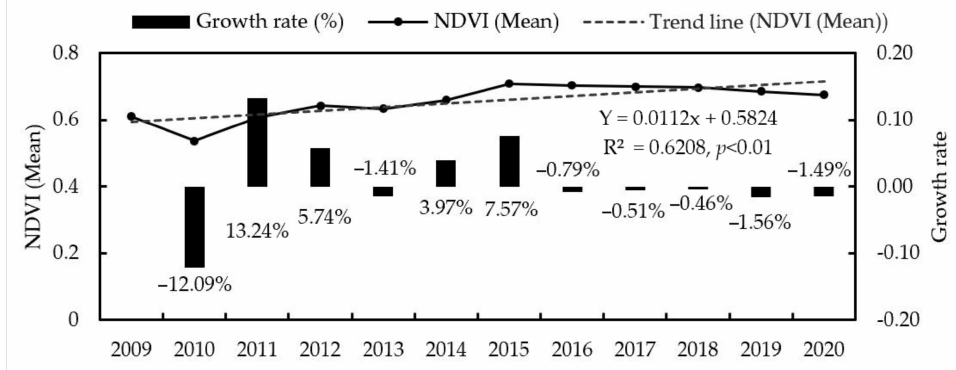
Figure 7. Variation in mean NDVI values in the study area from 2009 to